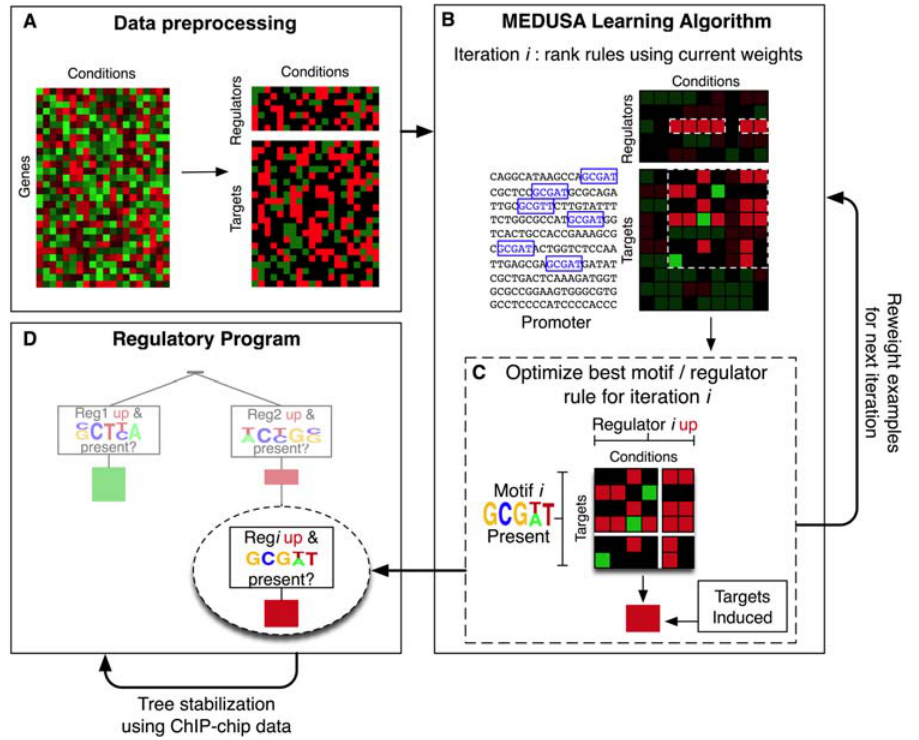
Figure 2. A schematic flow chart showing the algorithmic steps for learning the oxygen regulatory program with MEDUSA. (A) The mRNA expression data is discretized into three states, up (over-expressed), down (under-expressed), and baseline (not significantly differentially expressed), and genes are partitioned into potential regulators (transcription factors and signal transducers) and targets. The regulators are also included in the list of target genes so that their transcriptional regulation can be modeled. (B) The MEDUSA learning algorithm is presented with the promoter sequences of target genes, the discretized expression profiles of the regulators across multiple conditions, and the differentially expressed (up and down) target gene examples from these experiments. Baseline examples are not used to train MEDUSA. In the first stage of training, MEDUSA considers rules based on promoter sequence data and regulator expression states. MEDUSA uses a boosting strategy to avoid overfitting over many rounds of the algorithm. At each iteration i , a motif/regulator rule is chosen based on the current weights on the training examples; this rule predict that targets whose promoters contain the motif will go up (or down) in experiments where the regulator is over- (or under-) expressed. Before the next iteration, the examples are reweighted to emphasize the ones that are difficult to predict. (C) To learn the sequence motif, the algorithm agglomerates predictive k -mer sequences to produce candidate PSSMs, and it optimizes both the choice of PSSM and the probabilistic threshold used to determine where the hits of the motif occur. (D) At the end of each round of training, motif /regulator rules are placed into an alternating decision tree, building a global regulatory program. This regulatory program can be used to predict target gene up/down regulation for gene- experiment examples that were not seen in training. In order to produce a more stable decision tree, we perform a second pass of the tree-learning algorithm using a stabilized variant of boosting that gives more consistent models over different subsets of the training data. At this stage, both the motifs learned previously by MEDUSA and TF occupancies from ChIP-chip experiments are used as sequence features for the final regulatory program.